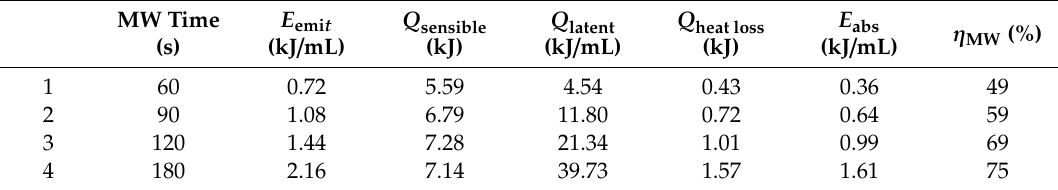
Table 1. Energy distribution in the microwave (MW) irradiation of poly(vinyl alcohol) (PVA) solutions as a function of the exposure time.